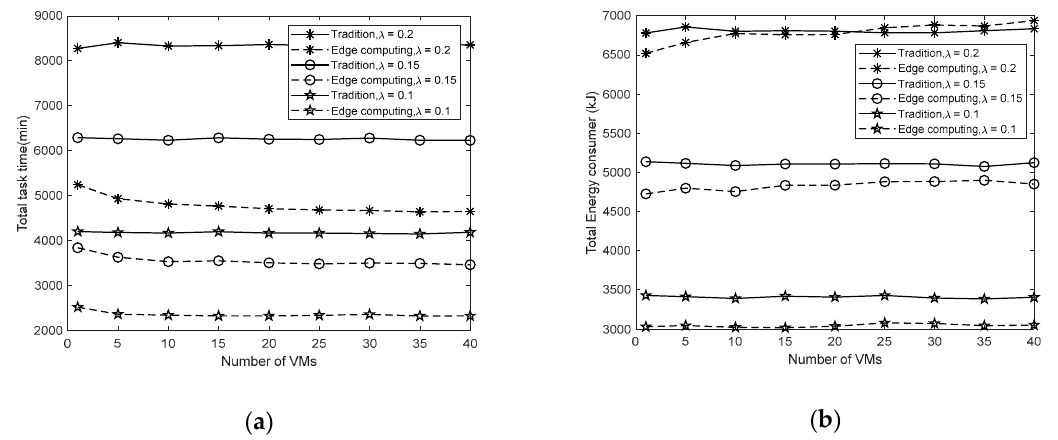
Figure 7. ( a ) the total time spent in terms of the number of VMs on satellite; ( b ) the total energy consumption in terms of the number of VMs on satellite.